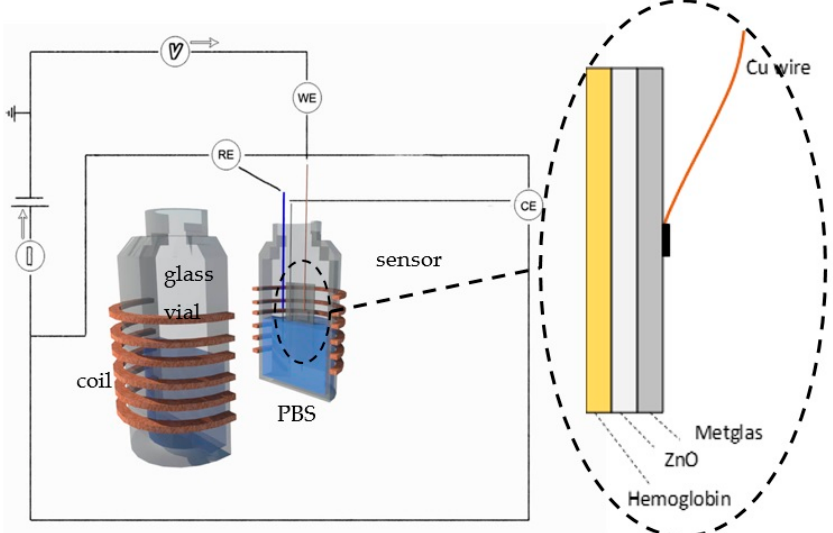
Figure 2. The detection experiment consisted of three electrodes, the sensor working electrode (WE), the Pt counter electrode (CE) and the Ag/AgCl reference electrode (RE), all immersed in a PBS buffer solution inside a glass vial on which a coil was wrapped externally.